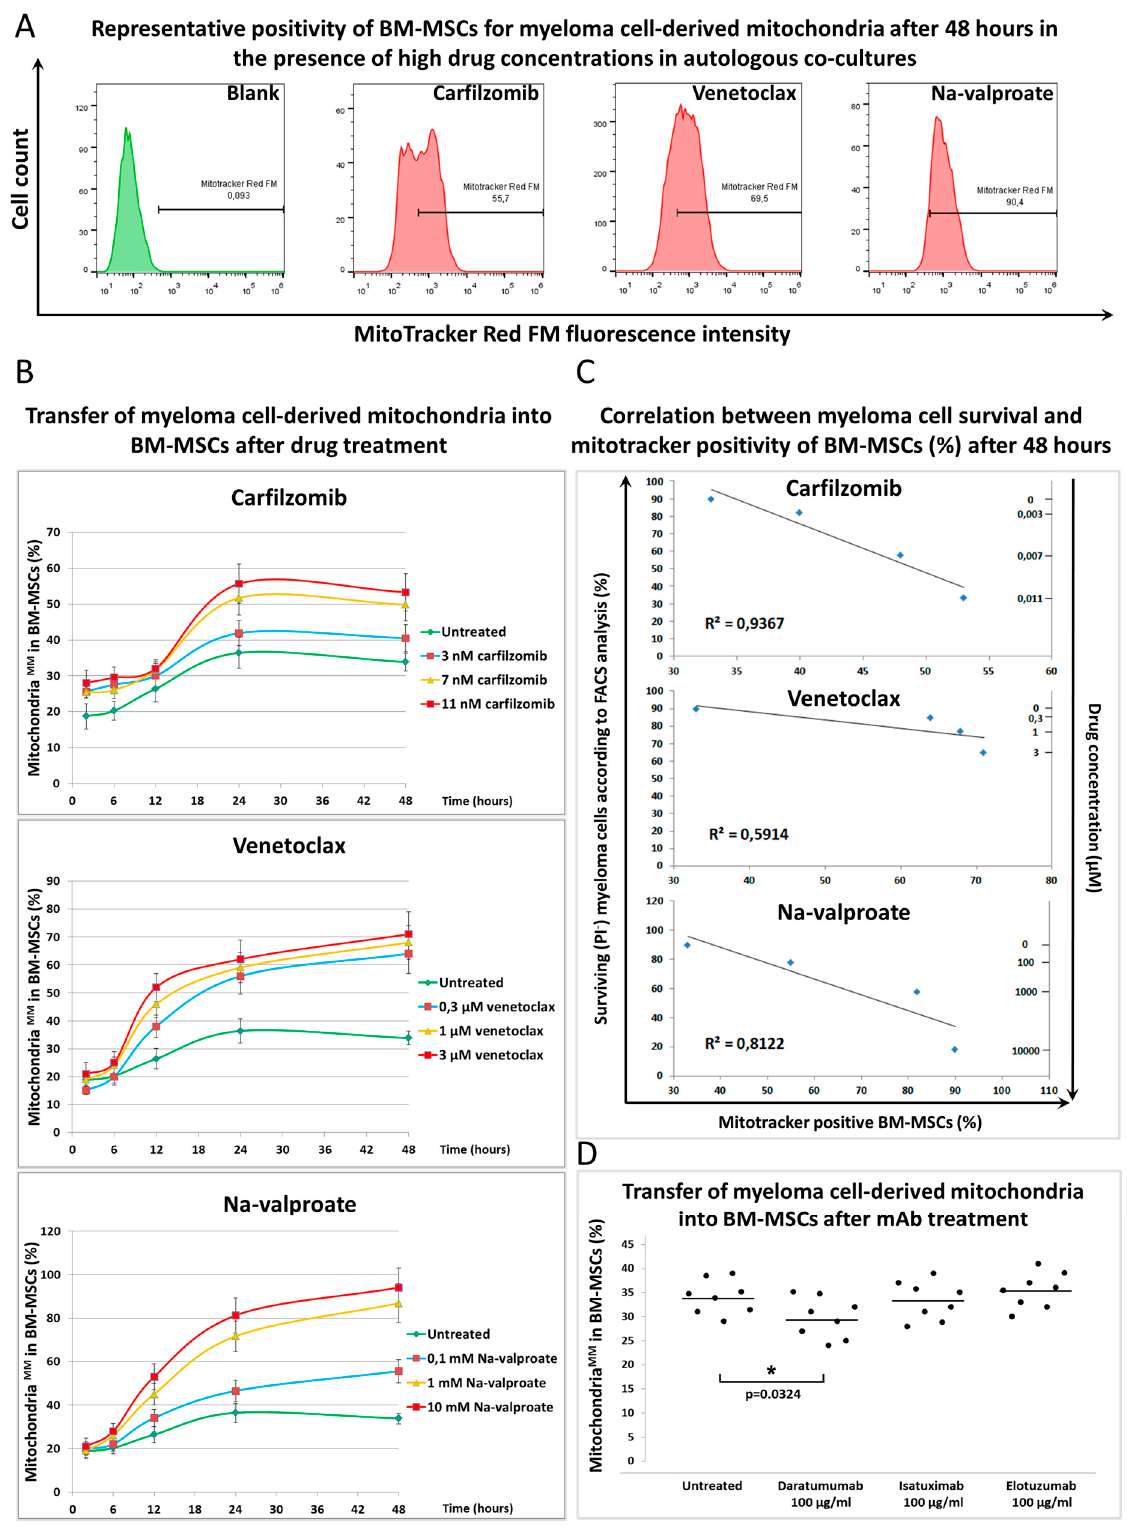
Figure 3. Mitochondrial transfer from myeloma cells to bone marrow stromal cells in the presence of chemotherapeutic drugs and therapeutic antibodies. ( A ) MMs were labeled with Mitotracker Red FM then co-cultured with BM-MSCs for 48 h in the presence or absence of the highest concentrations of each drug: 3 µM of venetoclax, 10 mM of Na-valproate, and 11 nM of carfilzomib. MM cell-derived mitochondria + BM-MSCs were analyzed by flow cytometry within the CD146 + BM-MSC population. ( B ) Mitotracker Red FM-labeled MMs and BM-MSCs were co-cultured for 2, 6, 12, 24, and 48 h in the presence or absence of carfilzomib (3, 7, or 11 nM), venetoclax (0.3, 1, or 3 µM), Na-valproate (0.1, 1, or 10 mM), and